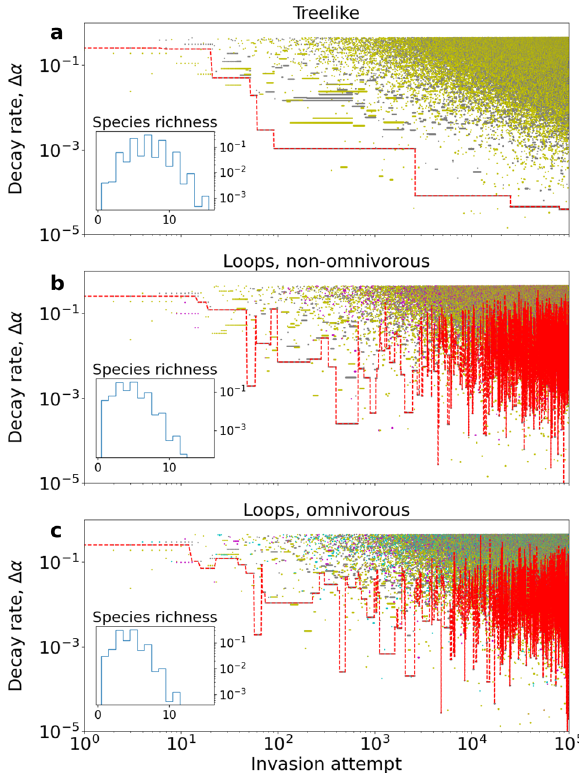
Figure 1. Evolution of three food webs using different assembly rules. All main panels show decay rates of all species present plotted against invasion attempts, that is, evolutionary steps. The decay rates are plotted as �α ≡ α − α min , where α min denotes the lower limit on decay rates ( compare : Table 1). The thin red line highlights the currently lowest producer decay rate. Grey symbols denote producers, yellow and magenta symbols denote consumers of one or two resources, respectively. Cyan symbols denote omnivores. ( a ) Food webs where only one resource per consumer is allowed, yielding a treelike food web without loops. ( b ) Consumers can have either one or two resources at the same trophic level. ( c ) Consumers are allowed one or two resources at any trophic level l ≥ 1 . Note that both axes use logarithmic scaling. Insets: Normalised histograms of species richness, using all data. Note the logarithmic vertical axis